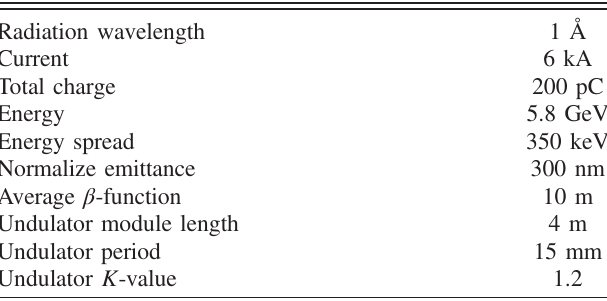
TABLE I. Electron and undulator parameters for SwissFEL taken as input for the